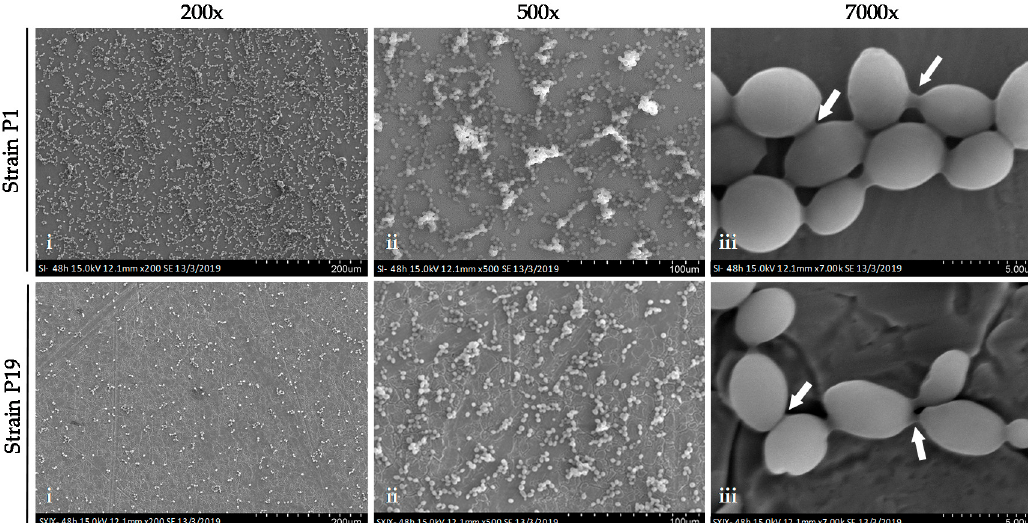
Figure 4. SEM observations of 48h-aged microcolonies for the strains P1 and P19 developed on stainless steel chips in YPD medium. (i) At 200 × : adhered cells; (ii) at 500 × : microcolonies and (iii) 7000 × : microcolonies with exopolymeric substances (EPS—indicated by white arrows).